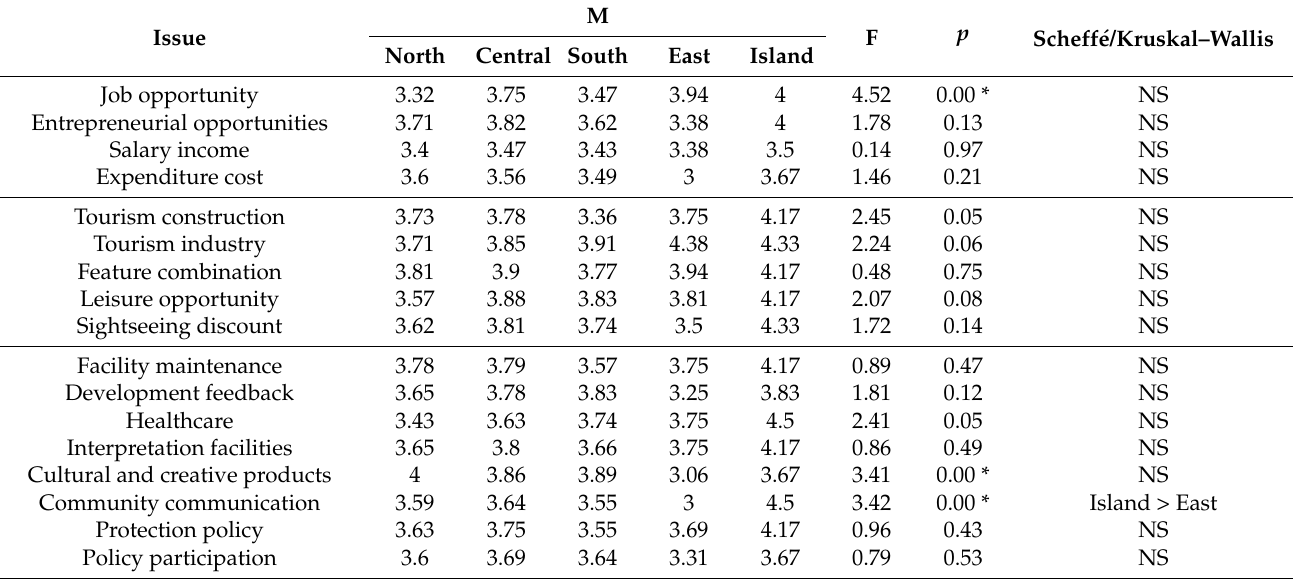
Table 4. Analysis of economic development cognition of tourists from different